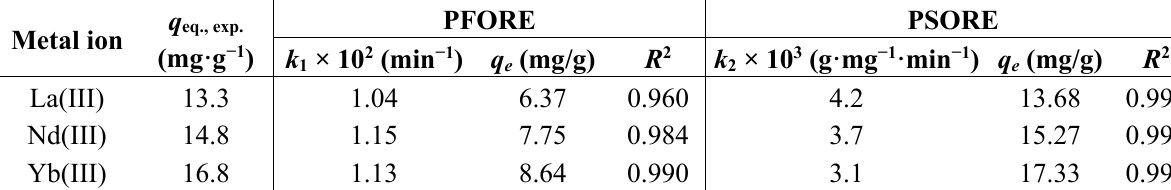
Table 1. Kinetics parameters of the pseudo-first order rate equation (PFORE) and the pseudo-second order rate equation (PSORE) for the sorption of La(III), Nd(III) and Yb(III) metal ions using cysteine-based magnetic-chitosan nanoparticles ( T : 27 °C; pH: 5). Metal